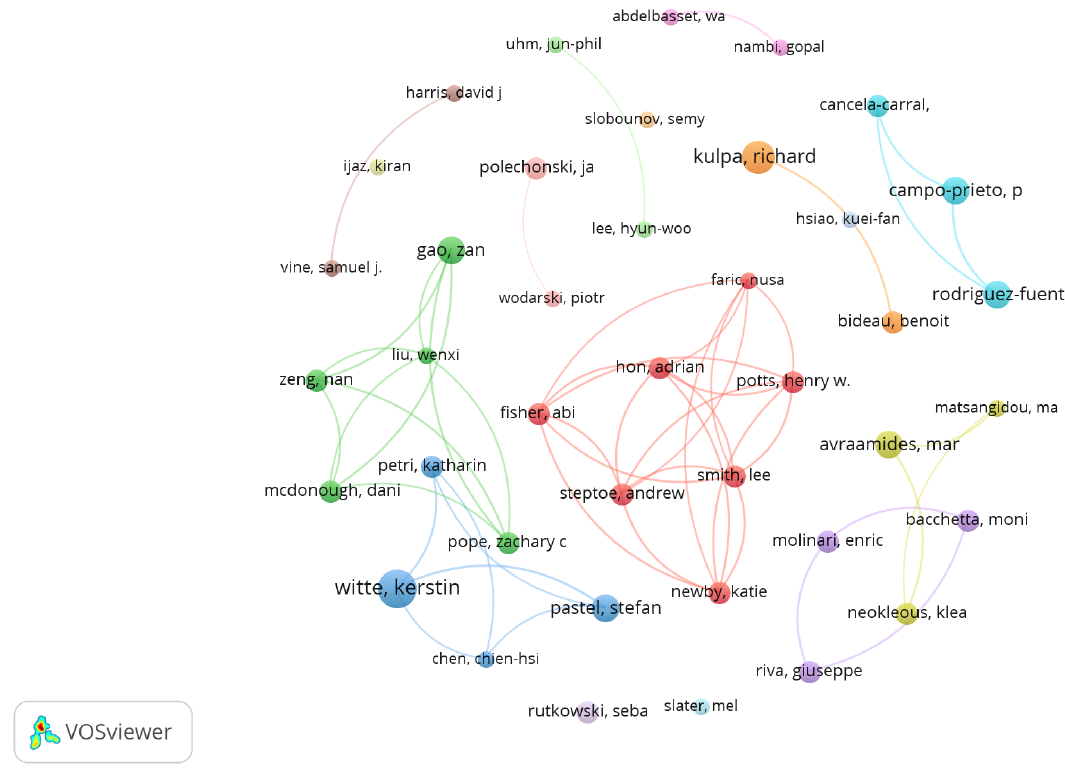
Figure 2. Most prolific co-authors and co-authoring connections. Analysis: fractionalization, attrac- tion: 10, repulsion: − 2.